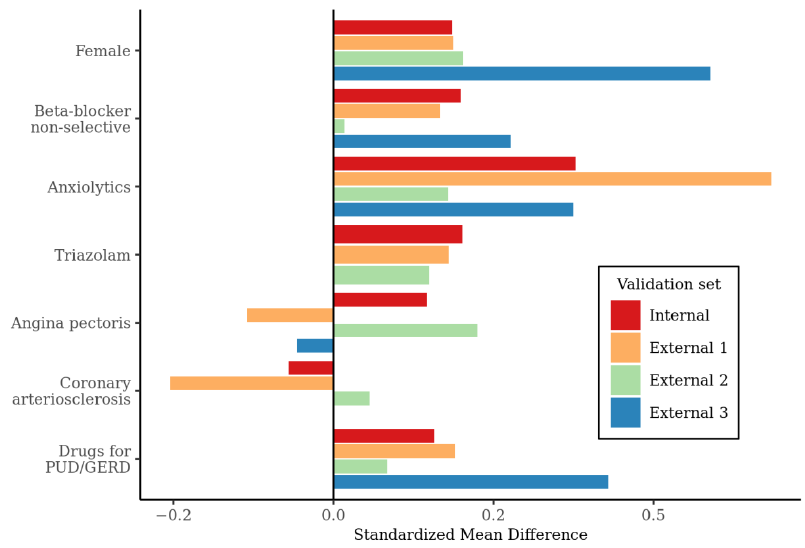
Figure 3. The comparison of the standardized mean di ff erences of the predictors of major depressive disorder across databases in which validation is done. Positive number of standardized mean di ff erence means that the variable is more frequent in outcome group than non-outcome group. PUD, peptic ulcer disease, GERD, gastro-esophageal reflux